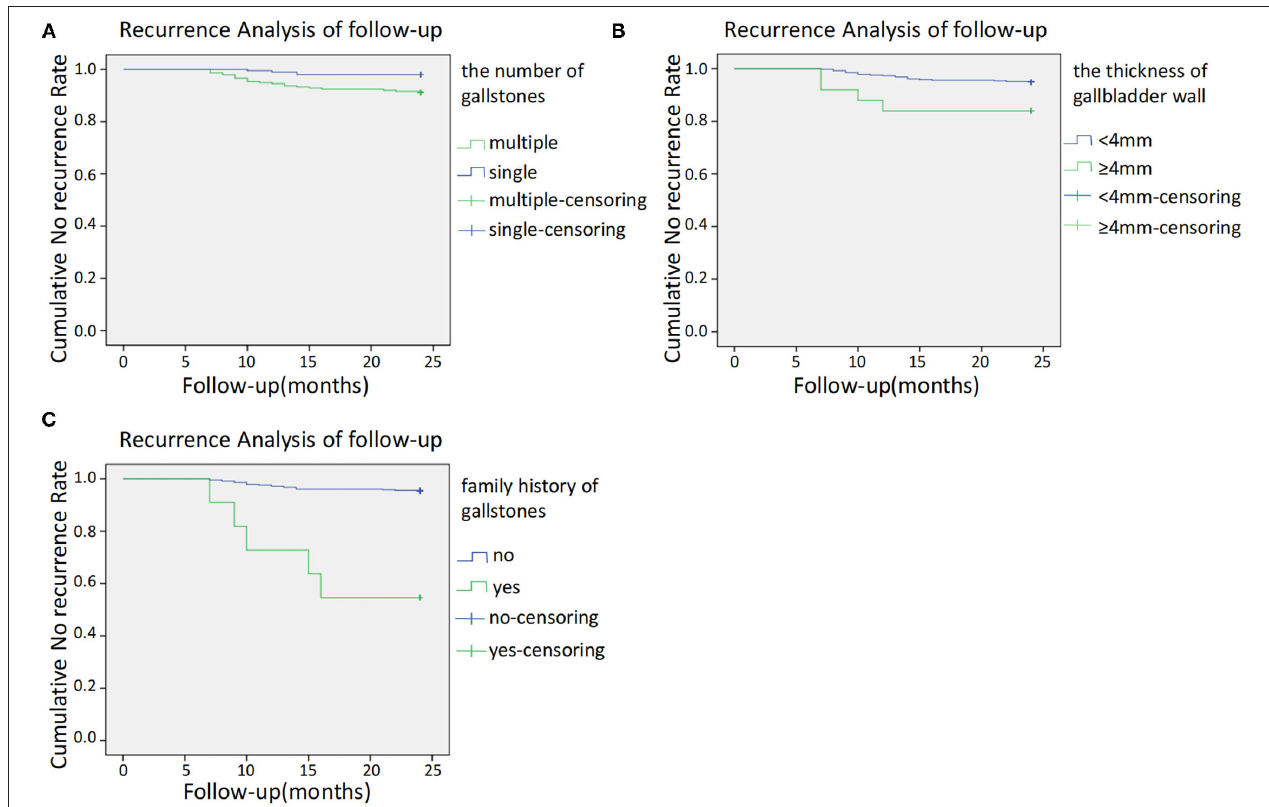
FIGURE 2 | (A) Kaplan–Meier cumulative no recurrence rate according to the number of gallstones. (B) Kaplan–Meier cumulative no recurrence rate according to a thickness of gallbladder wall. (C) Kaplan–Meier cumulative no recurrence according to family history.